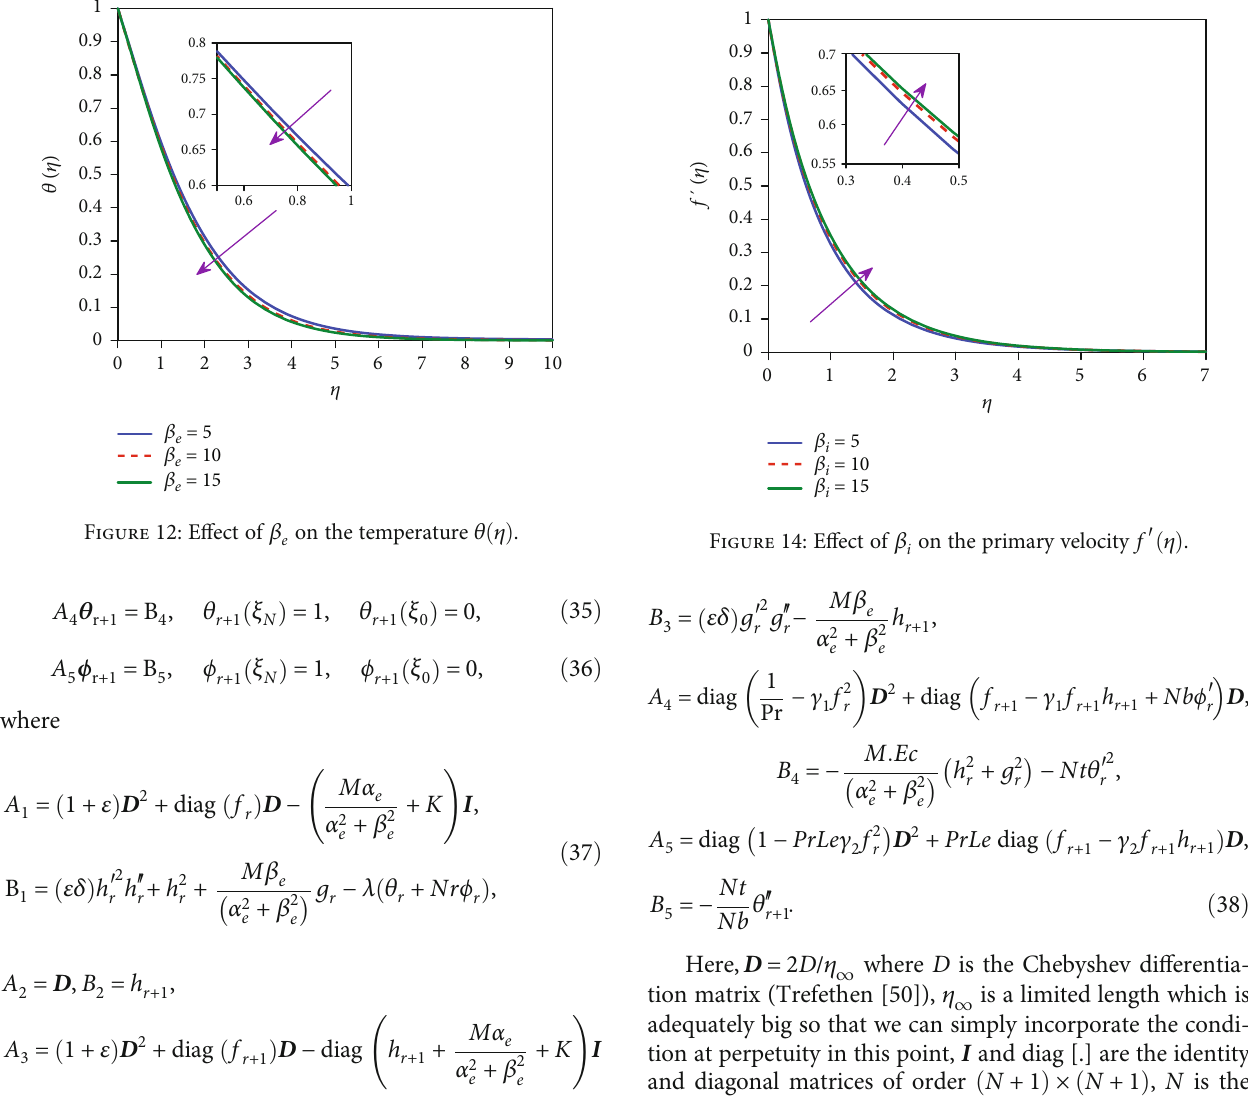
Figure 13: E ff ect of β